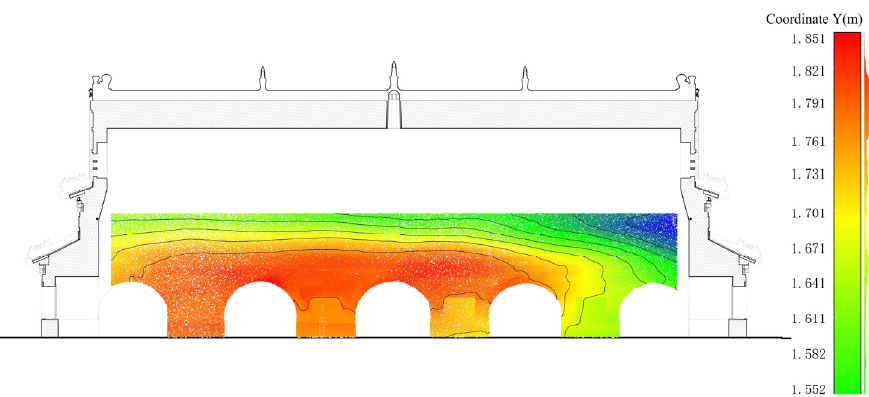
Figure 5. South wall deformation analysis of CA. The top of the image shows the verticality analysis of the wall surface, and the bottom shows the scatter diagram of the local section of the wall.